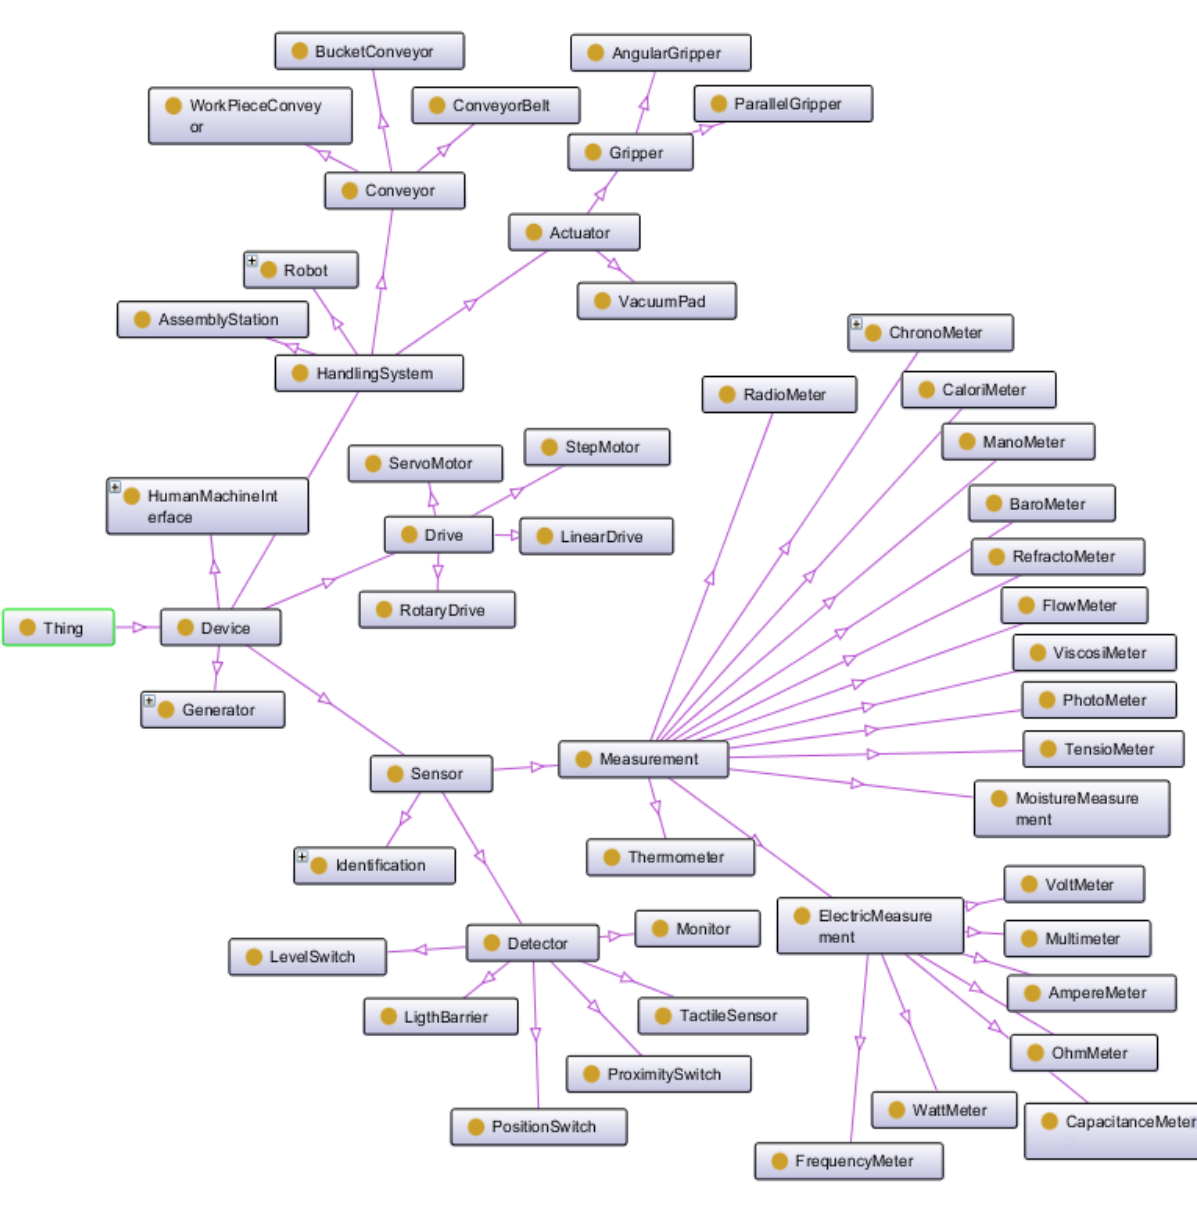
Figure 2. Part of the equipment